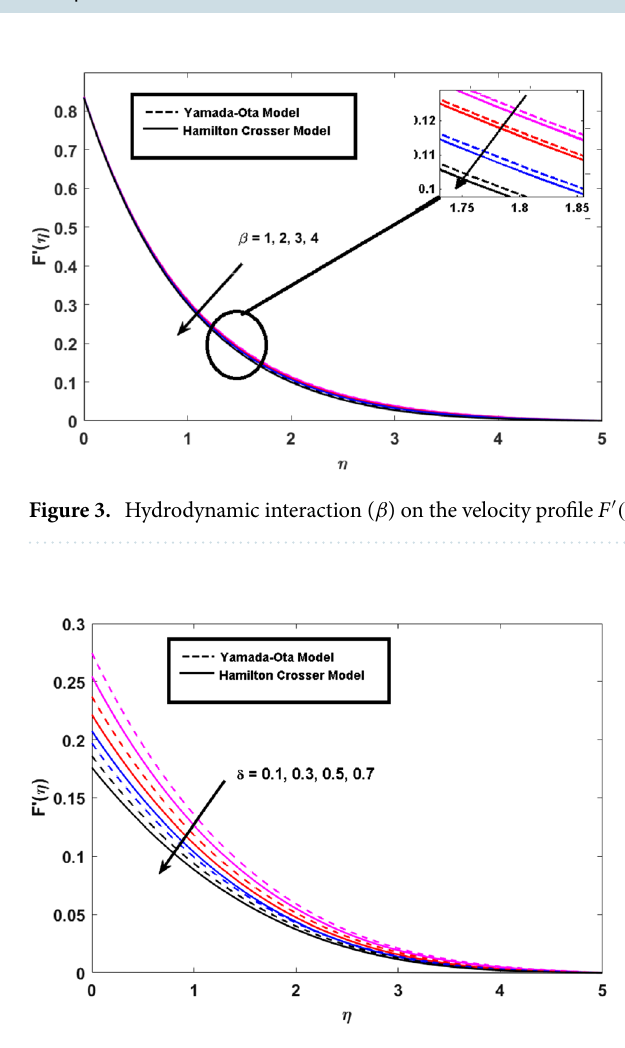
Figure 4. Slip parameter ( δ ) on the velocity profile F ′ (η) .